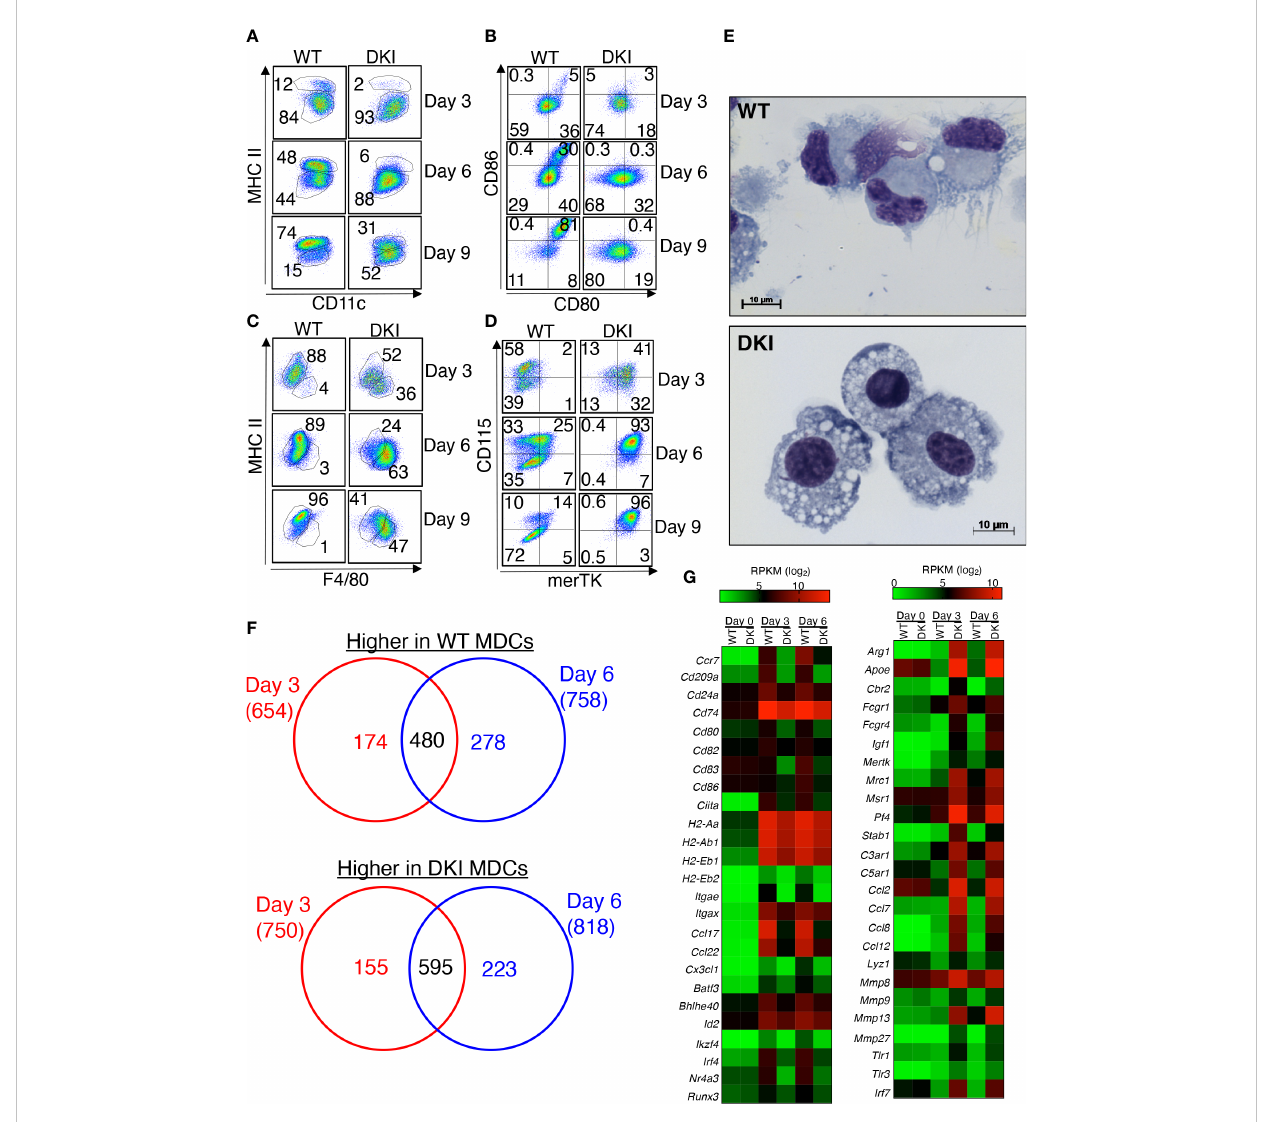
FIGURE 1 STAT5 Tetramers Promote moDC but Suppress Macrophage Differentiation. (A-G) Bone marrow-derived monocytes were isolated from WT and DKI mice. Monocytes were stimulated with 20 ng/ml GM-CSF for 3, 6, or 9 d. On either day 3, 6, or 9 differentiated cells were harvested for downstream analysis. (A-D) Representative dot plots showing the expression of CD11c and MHCII (A) , CD80 and CD86 (B) , F4/80 and MHCII (C) , and merTK and CD115 (D) following 3, 6, and 9 days of differentiation. Representative dot plots are from 3 independent experiments. (E) Representative Wright- Giemsa staining on differentiated WT and DKI MDCs following 8 d differentiation from 3 independent experiments. (F, G) RNA was isolated from WT and DKI unstimulated monocytes (day 0) and MDCs following 3 and 6 days of differentiation with GM-CSF. (F) Venn diagram comparing STAT5 tetramer-dependent genes that were differentially expressed following 3 and 6 d of differentiation. (G) Heatmap showing the expression levels (RPKM; log 2 ) of selected moDC-associated genes (left) and macrophage-associated genes (right) in WT and DKI MDCs. (F, G) Data are combined from 3 independent